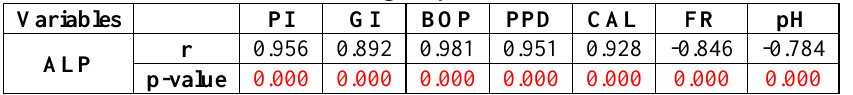
Table 7: Pearson’s Correlation Coefficient (r) between Clinical Periodontal Parameters (PLI, GI, BOP, PPD, CAL) and biochemical parameters (ALP) with salivary flow rate of the moderate group.